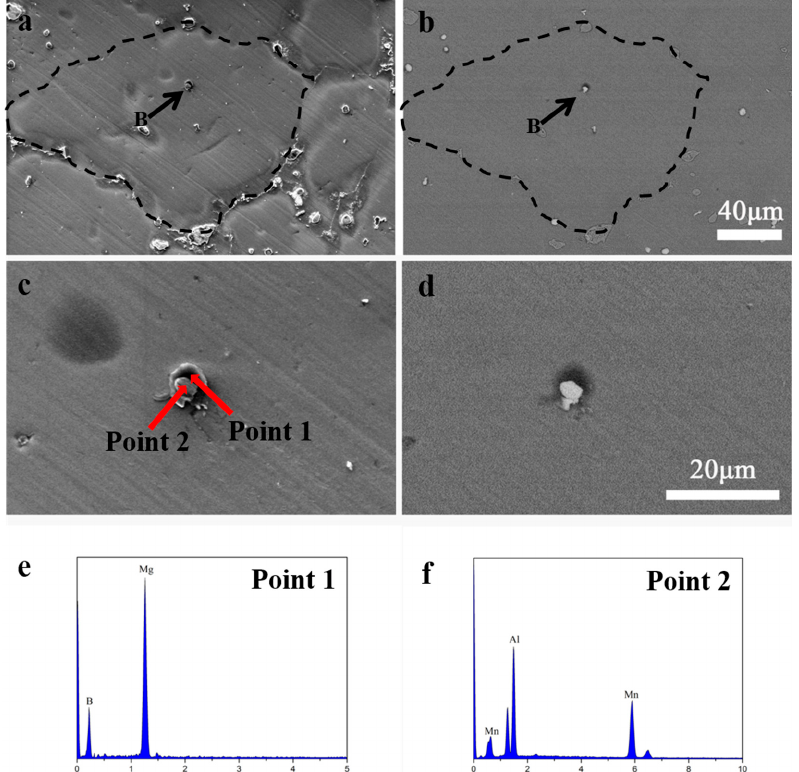
Figure 8. SEM micrograph of 0.1wt% B added AM50containing 0.1 wt. % B: ( a ). SE mode, ( b ). BSE mode ( c ). high magnification image of the particle B in SE mode ( d ). high magnification image of the particle B in BSE mode ( e ). the EPMA point result of point 1 ( f ). the EPMA point result of point 2. Table 3. EPMA results of the Figure 6 (at. %).